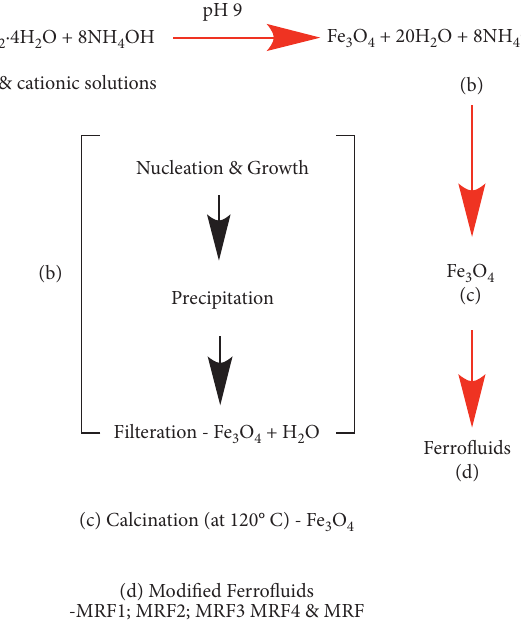
Figure 1: Flow diagram of the chemical co-precipitation